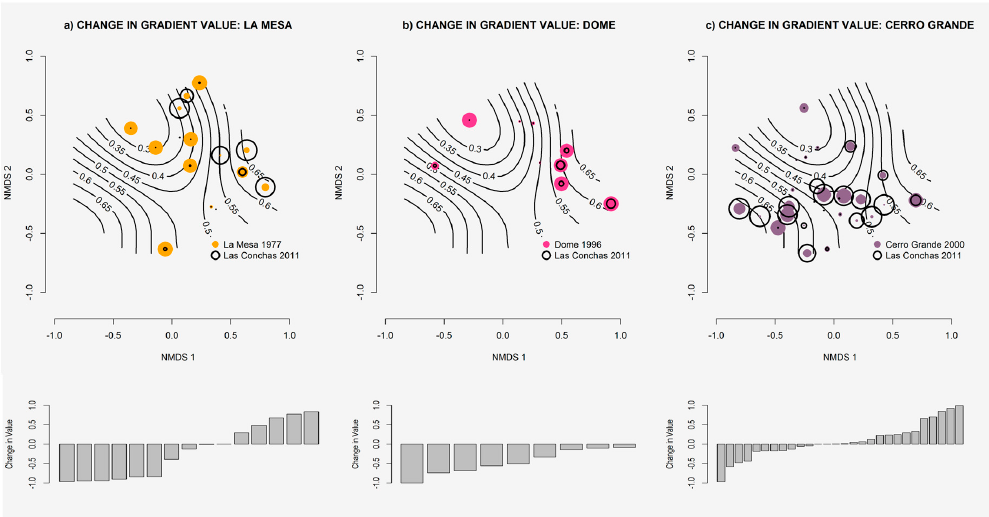
Figure 5 Figure 5. Ordination diagrams and bar charts illustrating refugial neighborhood dynamics following La Mesa ( a ), Dome ( b ) and Cerro Grande ( c ). Circular symbols representing sites are displayed on the Las Conchas RG (black contours), as in Figure 4, but here, site symbols are scaled by RG value for past fires (solid colored circles) and Las Conchas (black open circles). Bar charts below each ordination diagram show the magnitude (height of bar) and direction (distribution of values above or below zero) of change in refugial neighborhood density for each re-burned field